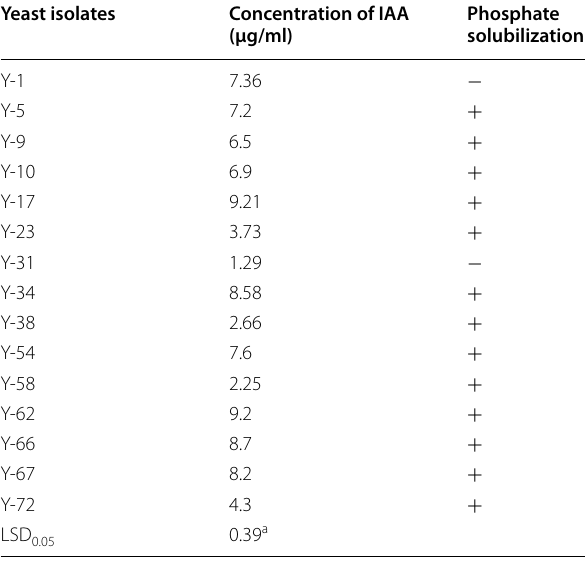
, clear zone formation; , no zone formation + − a Mean values for IAA in columns showing differences greater than LSD values are significantly different at p < 0.05